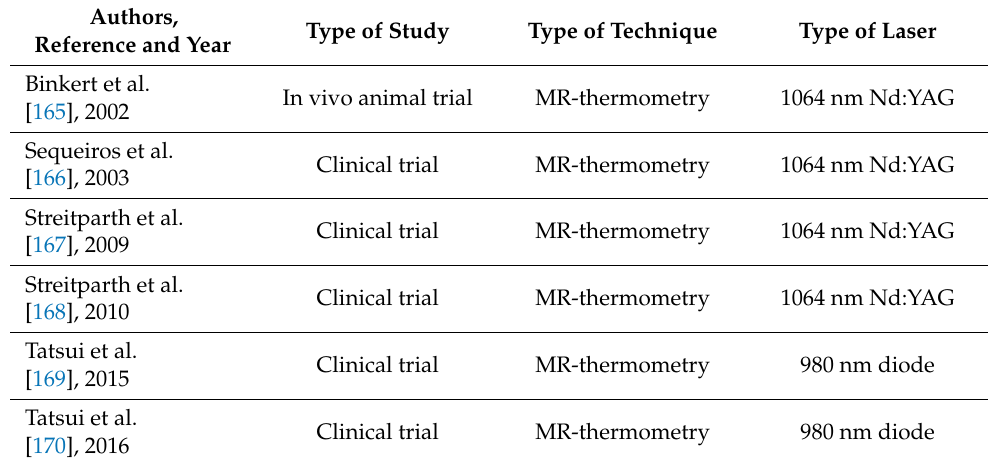
Table 3. Scientific articles describing temperature monitoring during LA in